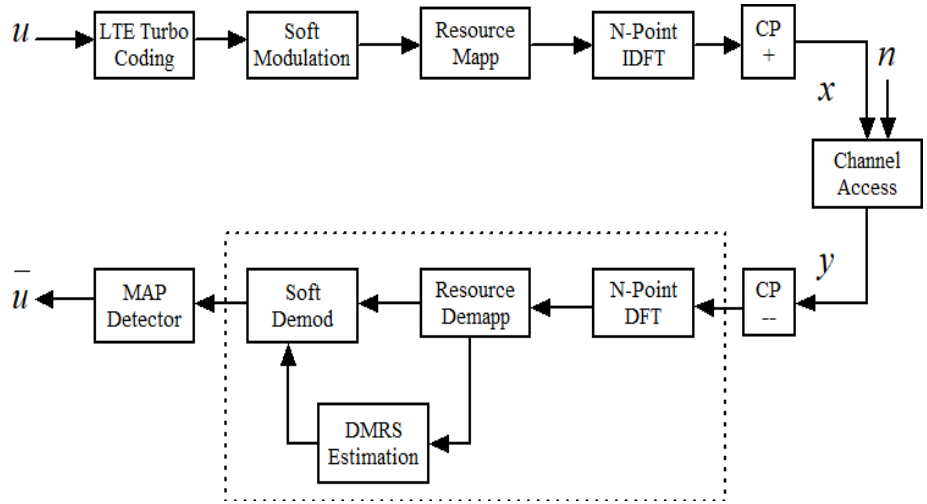
Figure 2. System model of LTE based uplink NB-IoT systems.